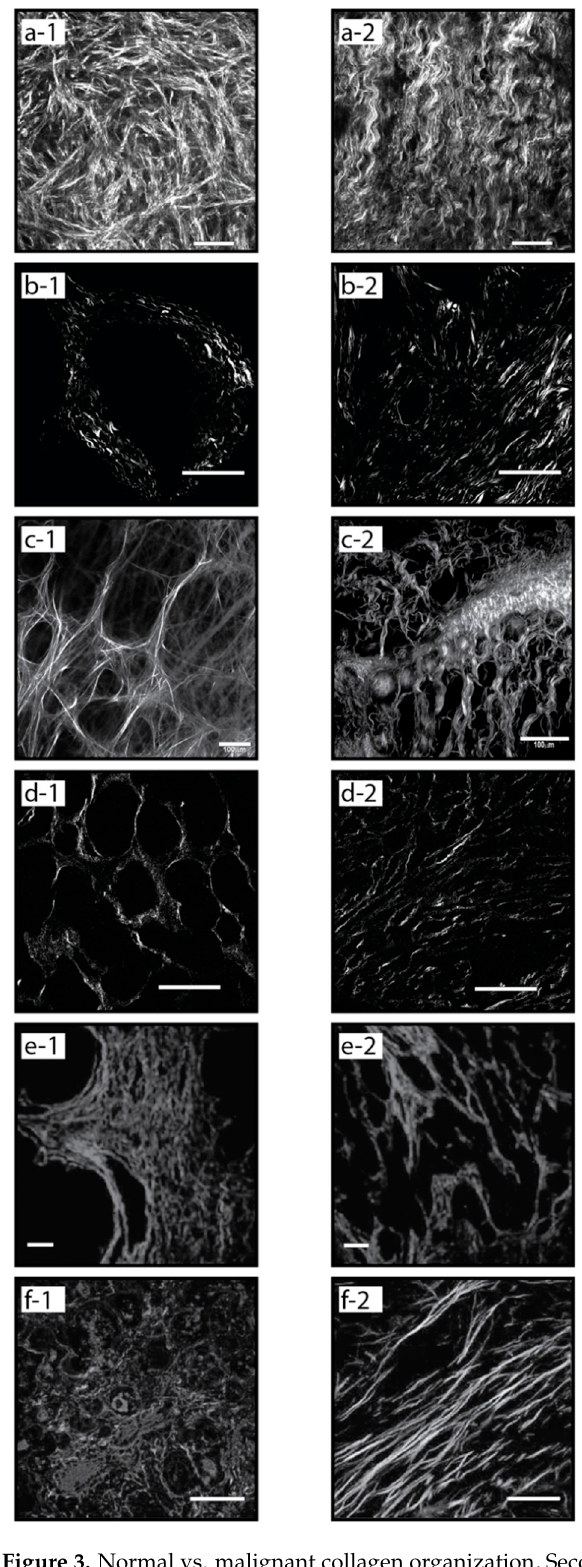
Figure 3. Normal vs. malignant collagen organization, Second Harmonic Generation (SHG) images from different cancer types showing characteristic signatures: normal ( a-1 ) and malignant ( a-2 ) ovarian tissue [9], normal ( b-1 ) and high grade ( b-2 ) pancreatic (PDAC) tissue [59], normal ( c-1 ) and malignant ( c-2 ) breast tissue, low grade ( d-1 ) and high grade ( d-2 ) kidney (RCC) tissue [94], normal ( e-1 ) and high grade ( e-2 ) prostate tissue [93], normal ( f-1 ) and malignant ( f-2 ) esophageal tissue [10].